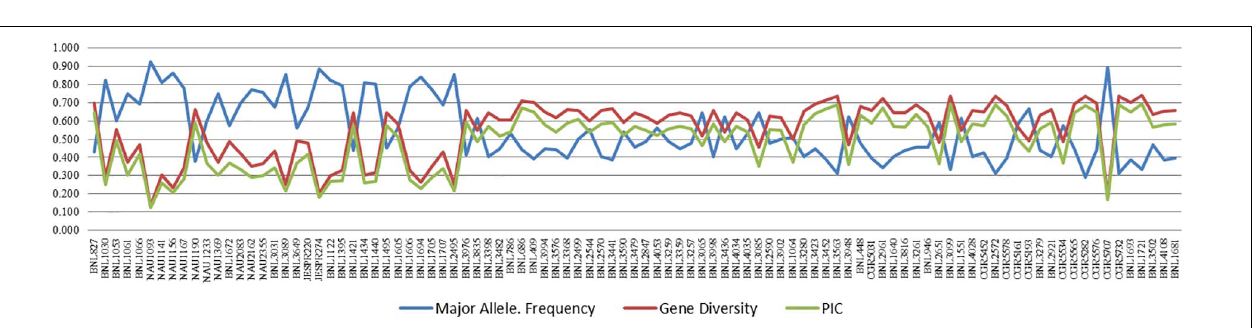
FIGURE 2 | Variation in major allele frequency, gene diversity, and PIC for 97 polymorphic markers of cotton. A list of the markers on X -axis is also given in Supplementary Table 3